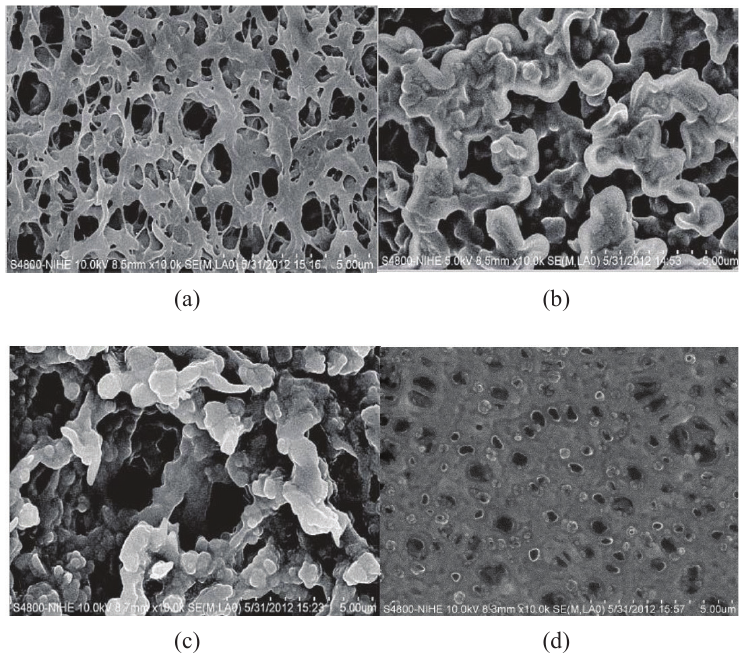
Fig. 4 – Surface of PVDF membranes before and after impregnation with dif­ ferent ILs (a: original, b: after impregnation with [OMIM][CH impregnation with [BMIM][CH